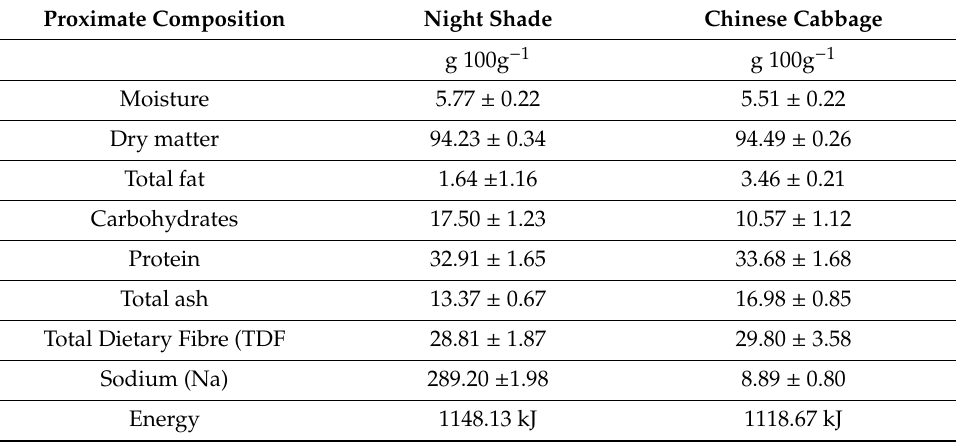
Table 13. Proximate composition of solar dried Nightshade and Chinese cabbage leaves. Proximate